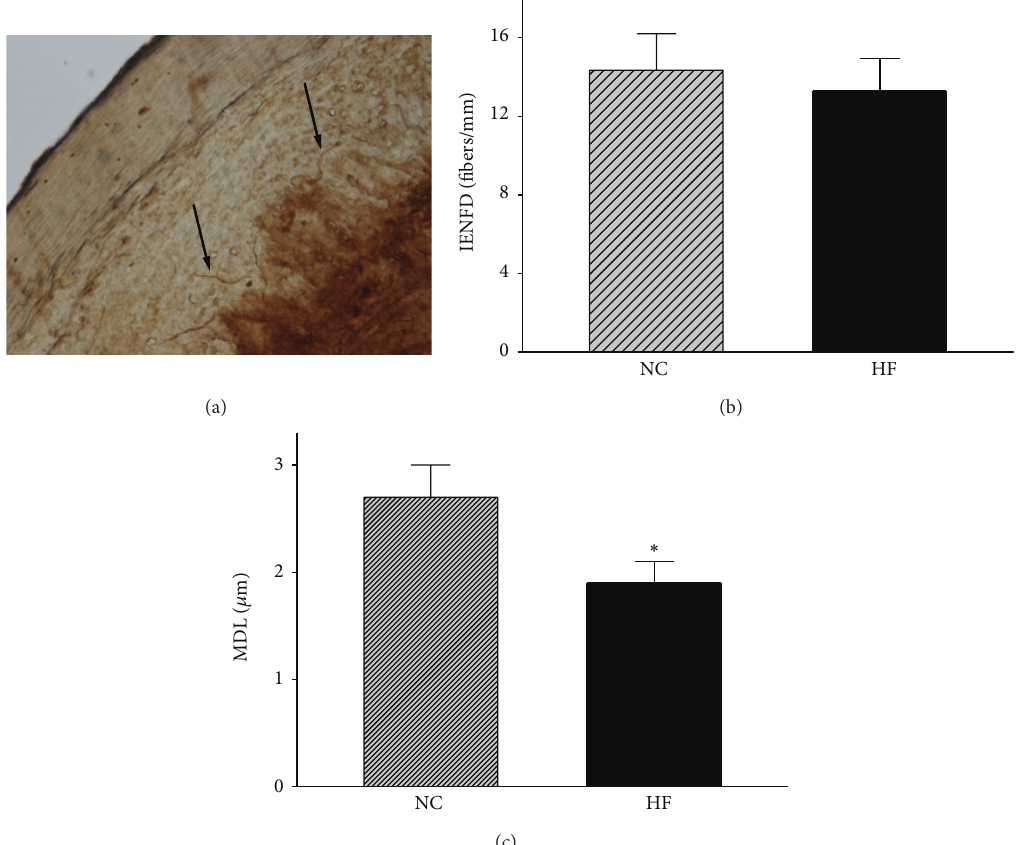
Figure 3: Intraepidermal nerve fiber profiles. (a) Representative image (original magnification × 200). (b) Intraepidermal nerve fiber density. (c) Mean dendrite length. NC and HF, abbreviations for “normal diet” and “high-fat diet,” represent the control and HFD-fed groups, respectively. Data are the mean ± SE, 𝑛 = 15 mice/group, and ∗ 𝑃 < 0.05 .